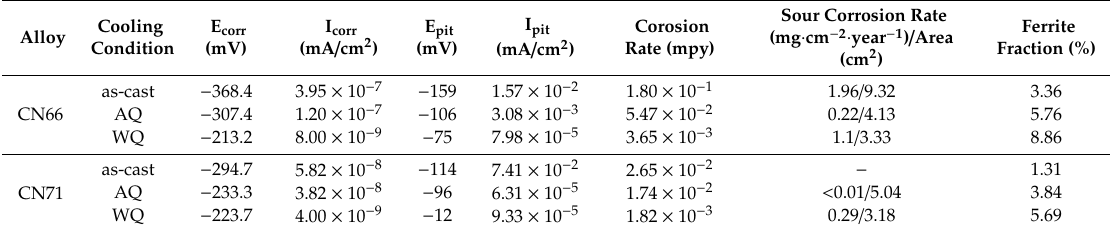
Table 2. The polarization test results and the sour corrosion rate of CN66 and CN71 with di ff erent heat treatment conditions (as-cast, AQ: solution treated and air-cooled, WQ: solution treated and water quenched), and its ferrite